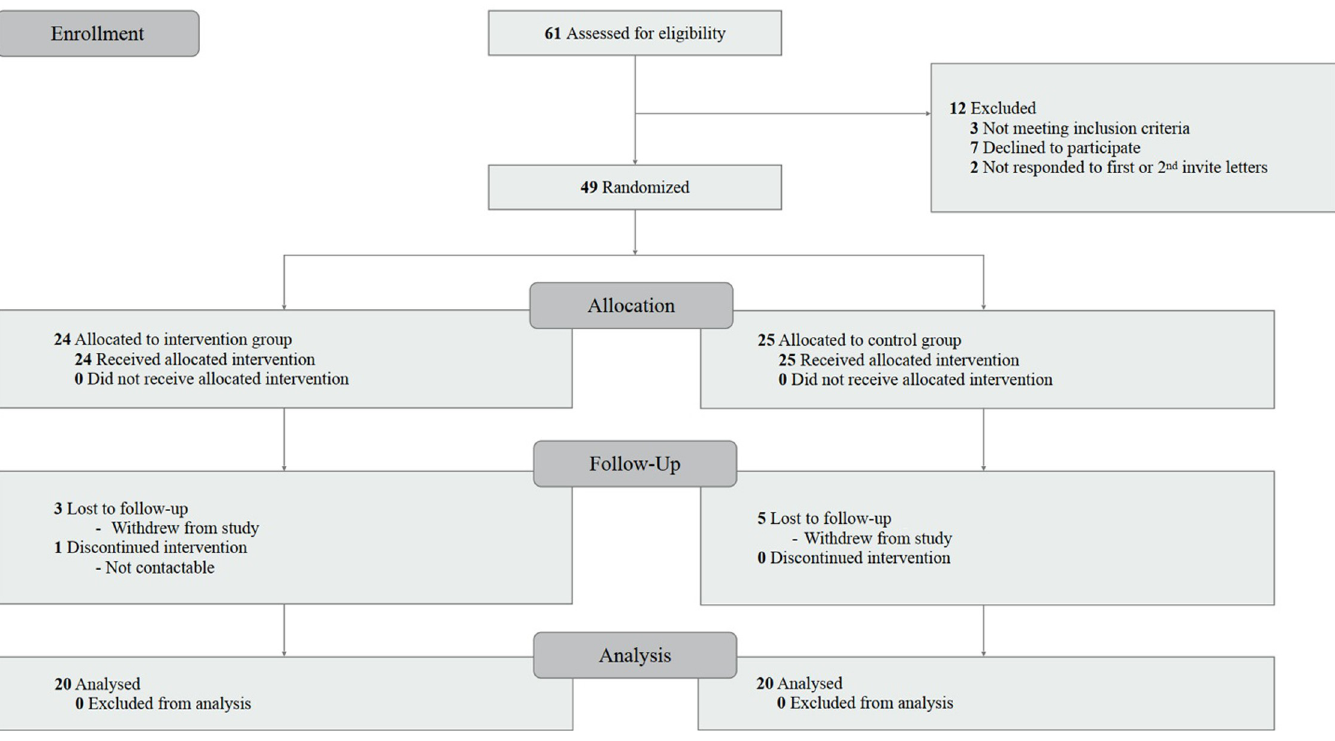
Fig 1. Flow chart of the